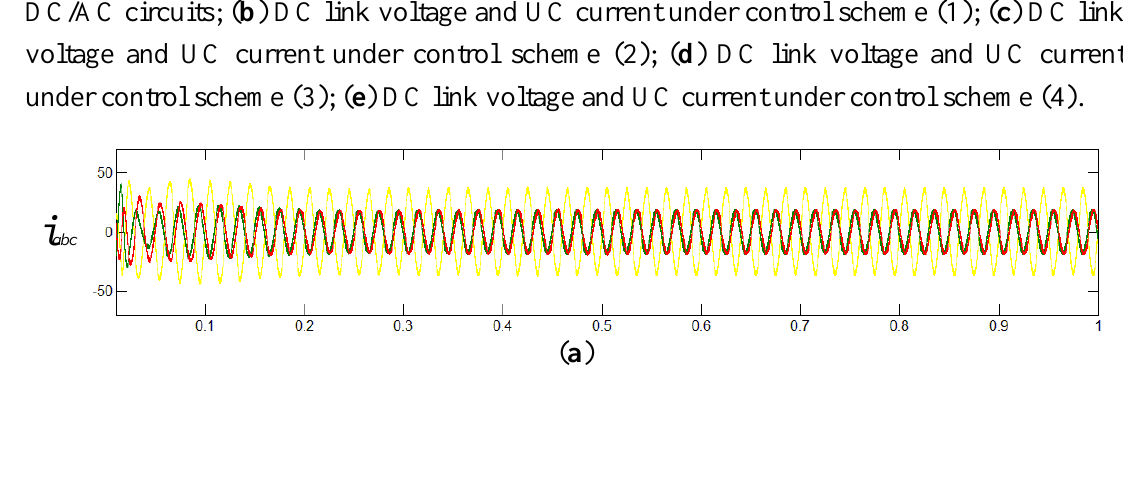
Figure 5. Zero-pole distributive chart of 𝐺